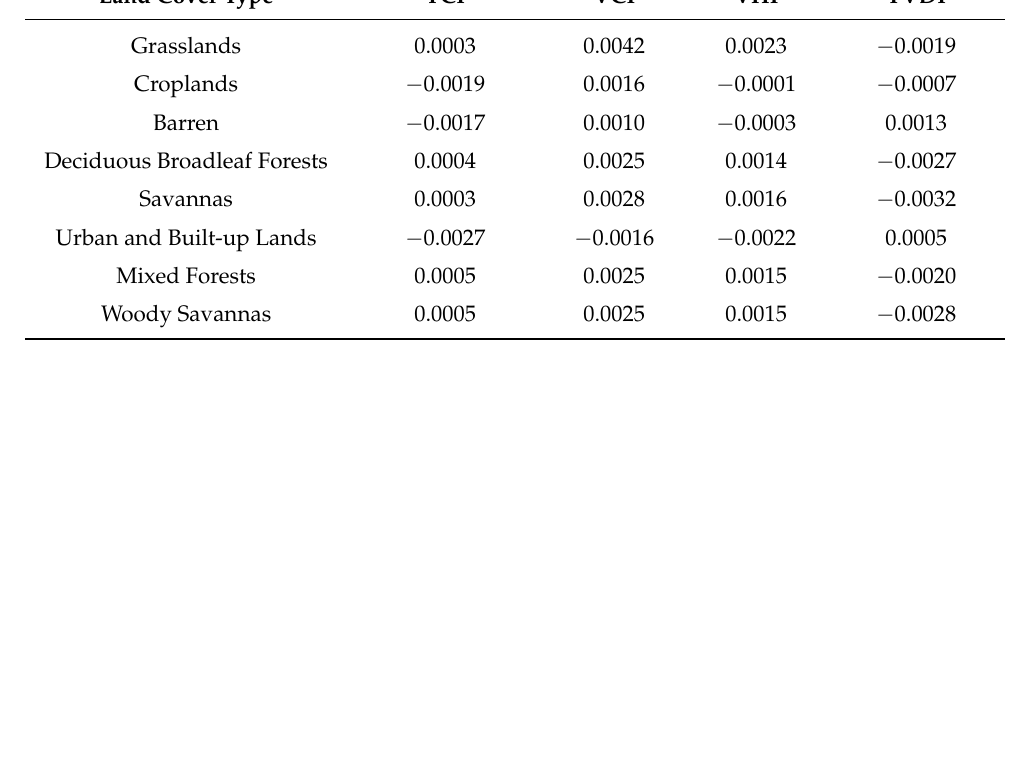
Table 8. Statistic of Slope in different land cover types.